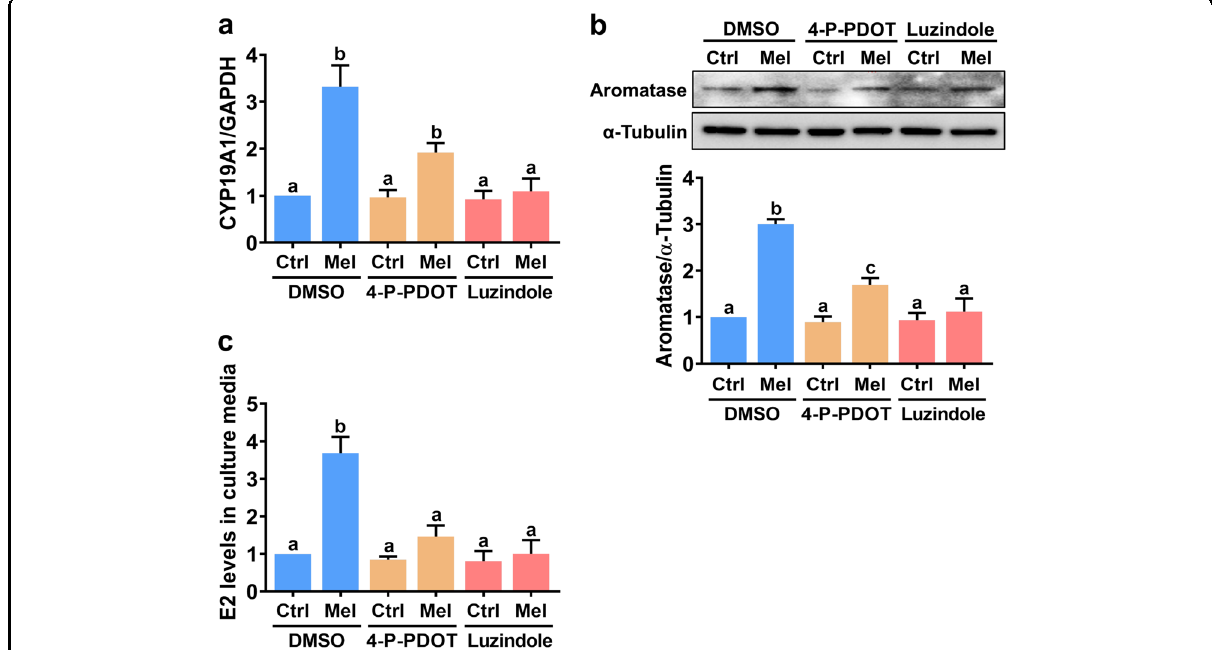
Fig. 2 MT1 and MT2 melatonin receptors mediate melatonin-stimulated aromatase expression and E2 production in primary hGL cells. a , b Cells were pretreated with vehicle control (DMSO), 10 µM 4-P-PDOT, or 10 µM luzindole for 30 min and then exposed to 500 µM melatonin for 24 h. Aromatase mRNA (CYP19A1) ( a ) and protein ( b ) levels were examined by RT-qPCR and western blotting, respectively. c Cells were pretreated with vehicle control (DMSO), 10 µM 4-P-PDOT, or 10 µM luzindole for 30 min and then exposed to 500 µM melatonin for 24 h. The E2 levels in culture media were examined by ELISA. The results are expressed as the mean ± SEM of at least three independent experiments. Values without a common letter are signi fi cantly different ( p <